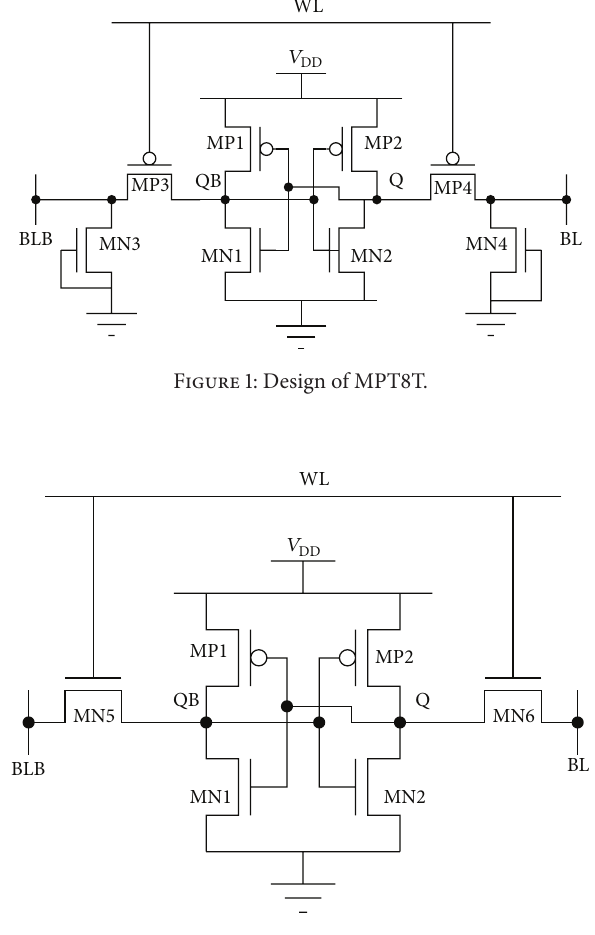
Figure 2: Design of